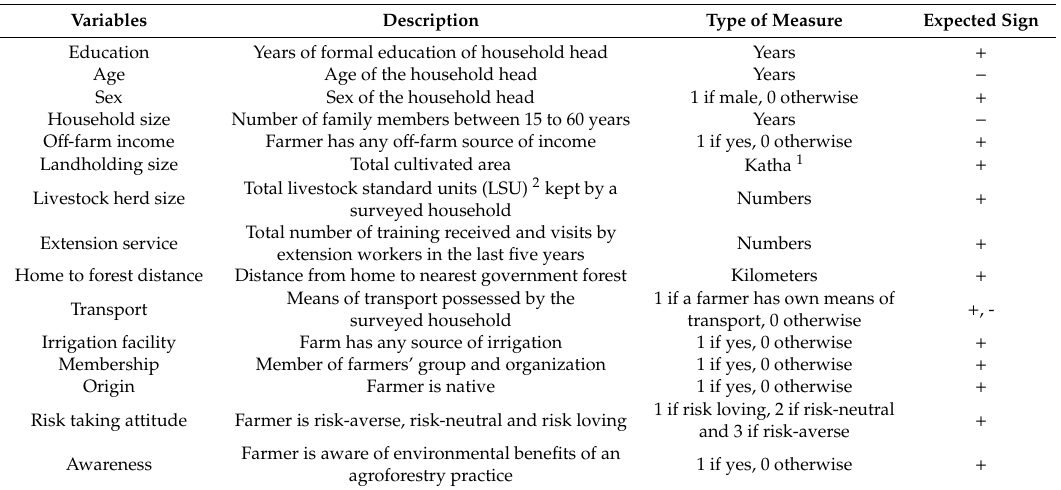
Table 1. Description of the independent variables specified in the multinomial logistic